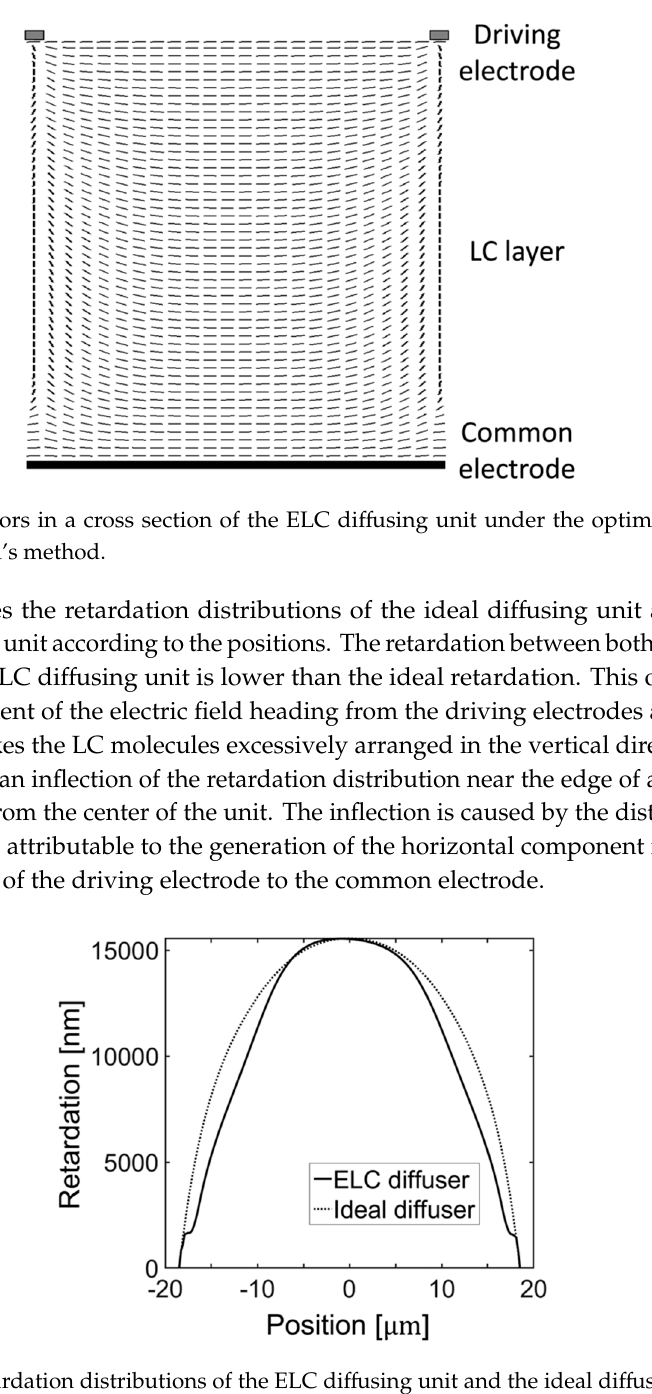
Figure 5. Retardation distributions of the ELC diffusing unit and the ideal diffusing unit.